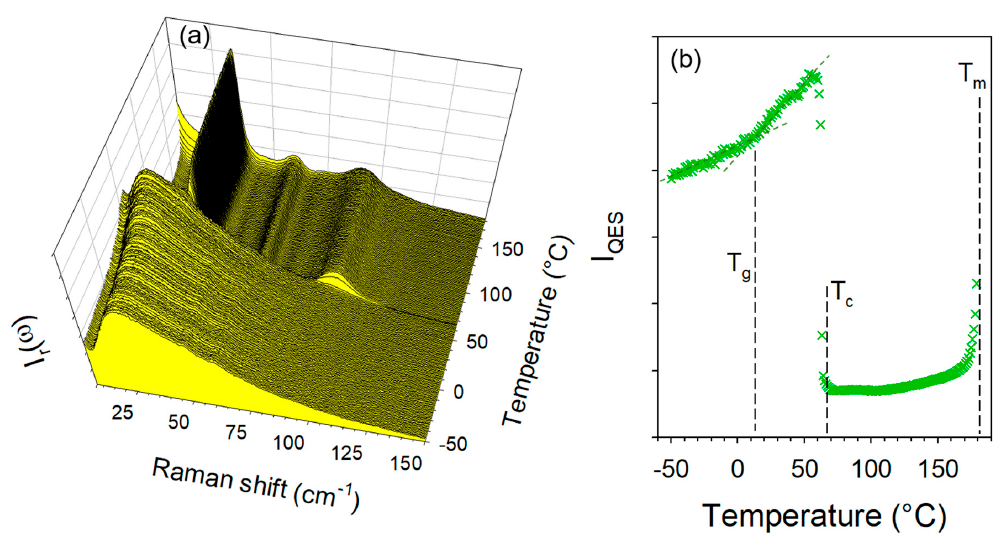
Figure 8. Low-frequency analysis of the heating run (1 °C/min) of the co-amorphous formulation obtained by co-milling anhydrous forms of theophylline and citric acid; ( a ) temperature dependence of the low-frequency spectrum; ( b ) temperature dependence of the quasielastic intensity obtained by integrating I r ( ω ) spectra in the very low-frequency region (<30 cm − 1 ). Figure 8a clearly shows the amorphous band-shape of the low-frequency spectrum at − 50 °C obtained by cooling the formulation just after cryo-milling. The absence of pho- non peaks indicates that the mixture of anhydrous forms of TP and CA was amorphized by co-milling at low-temperature. Significant changes in the low-frequency spectrum re- flect the phase transition sequence of the co-amorphous formulation upon heating, which can be better visualized by plotting the temperature dependence of the quasielastic inten- sity (I QES ) in Figure 8b. The first feature corresponds to a change in the slope of I QES (T) usually assigned to the glass transition [28,29], observed at T g = 10 °C. The second corre- sponds to a drop in intensity induced by crystallization (ordering process) at T c = 70 °C into the anhydrous form 1. The spectra taken above 70 °C can be identified as the spectrum the anhydrous co-crystal form 1obtained by heating form 1 ′ . The last feature is the increase in I QES associated with the melting of the co-crystal around T m = 185 °C. 2.3.2. Co-Milling at Room Temperature for 60 min It was reported that co-milling anhydrous TPa and CAa for 1 h makes it possible to obtain a co-crystal [9]. The LFRS of the sample obtained by the neat co-milling of